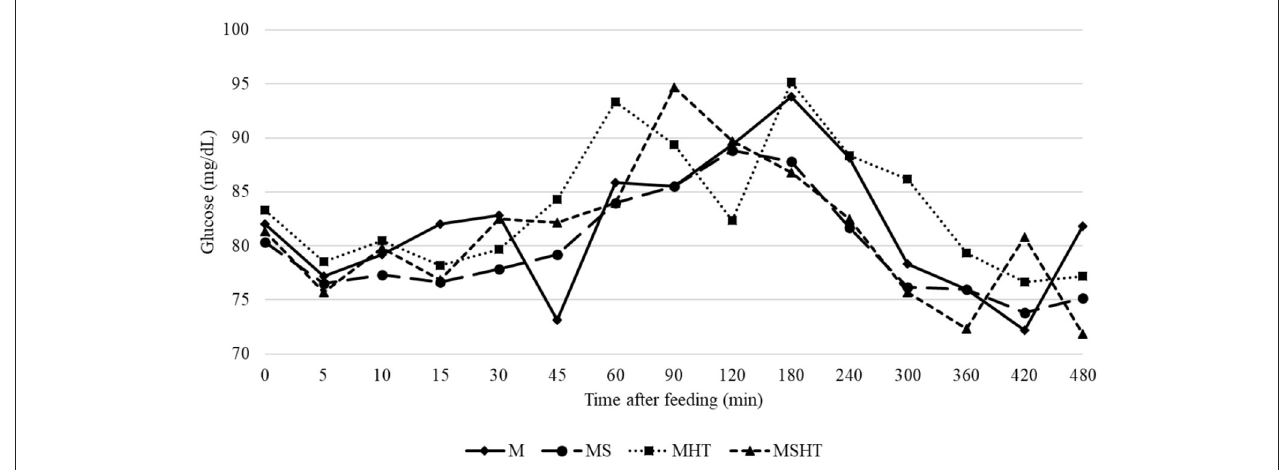
FIGURE 1 | Average postprandial glycemic curves of dogs fed the experimental diets (mg/dl). M, maize; MS, maize + sorghum; MHT, maize + hydrolysable tannins; MSHT, maize + sorghum + hydrolysable tannins. proanthocyanidins and their oligomers and polymers,